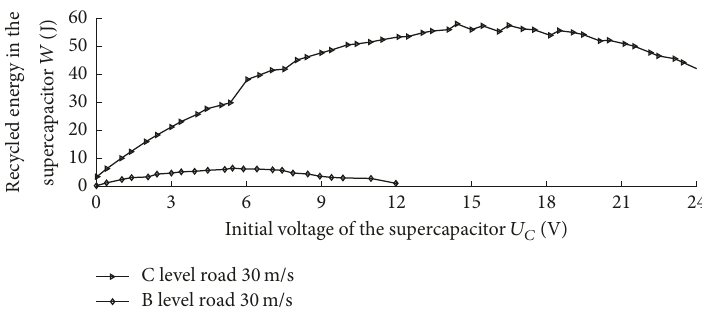
Figure 8: The relationship between recycled energy by the supercapacitor and the initial terminal voltage.